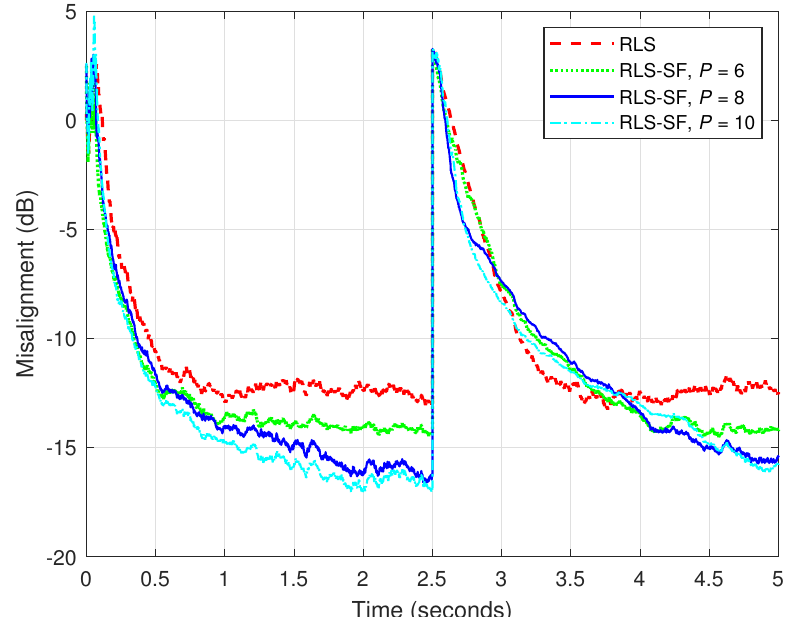
Figure 14. Performance of the conventional RLS filter [with λ = 1 − 1/ ( KL /2 ) ] and the RLS-SF [with λ 1 = 1 − 1/ ( 2 KPL 1 ) and λ 2 = 1 − 1/ ( 2 KPL 2 ) ], using K = 10, for the identification of the acoustic echo paths from Figure 1c,d. The input signal is an AR(1) process, SNR = 10 dB, and the echo path changes after 2.5